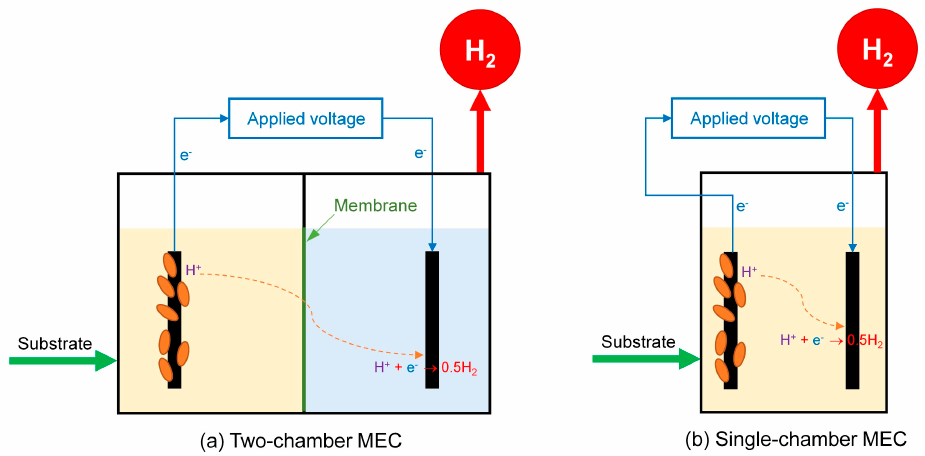
Figure 4. The schematic diagram of ( a ) two-chamber MEC and ( b ) single-chamber